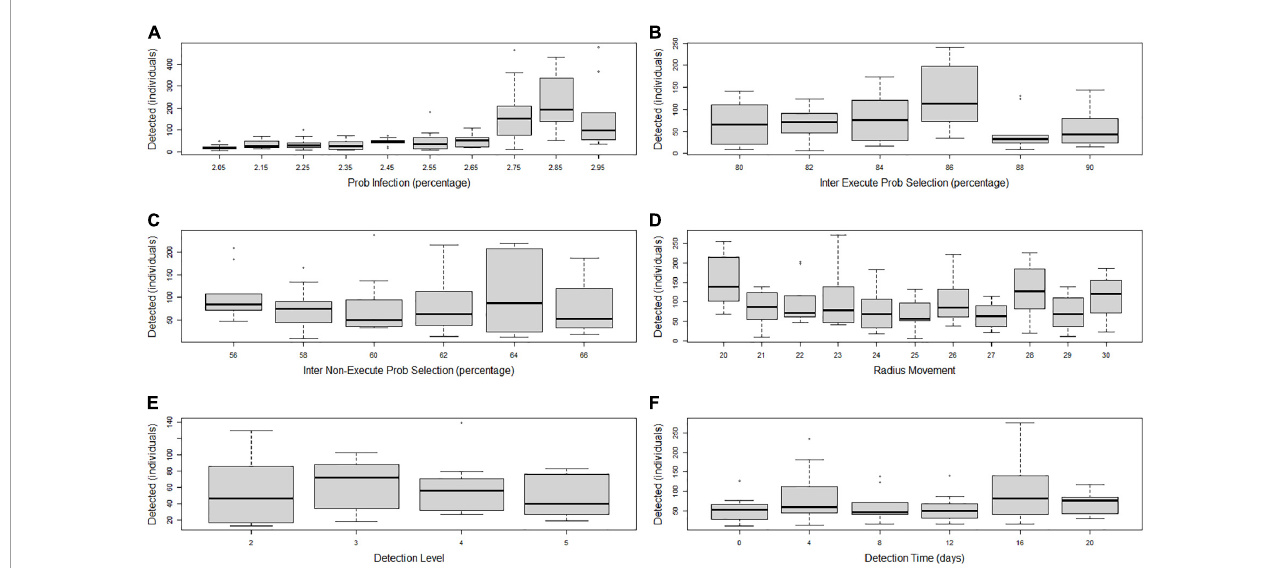
FIGURE5 Boxplot of the effect of the parameter change, including (A) probability of infection, (B) inter execute probability, (C) inter non-execute probability, (D) radius movement, (E) detection level, and (F) detection time, in the number of infected individuals for the SAMPAN model.